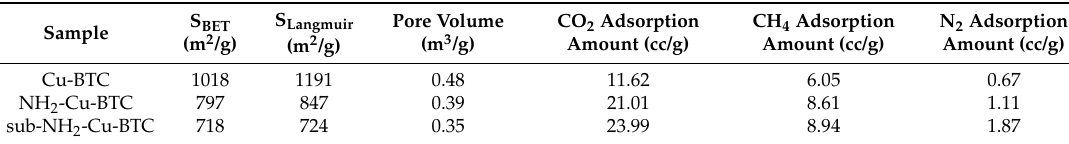
Figure 5. CO 2 , N 2 , and CH 4 adsorption isotherms of Cu-BTC at 308 K. Table 1. Physical and textural properties of